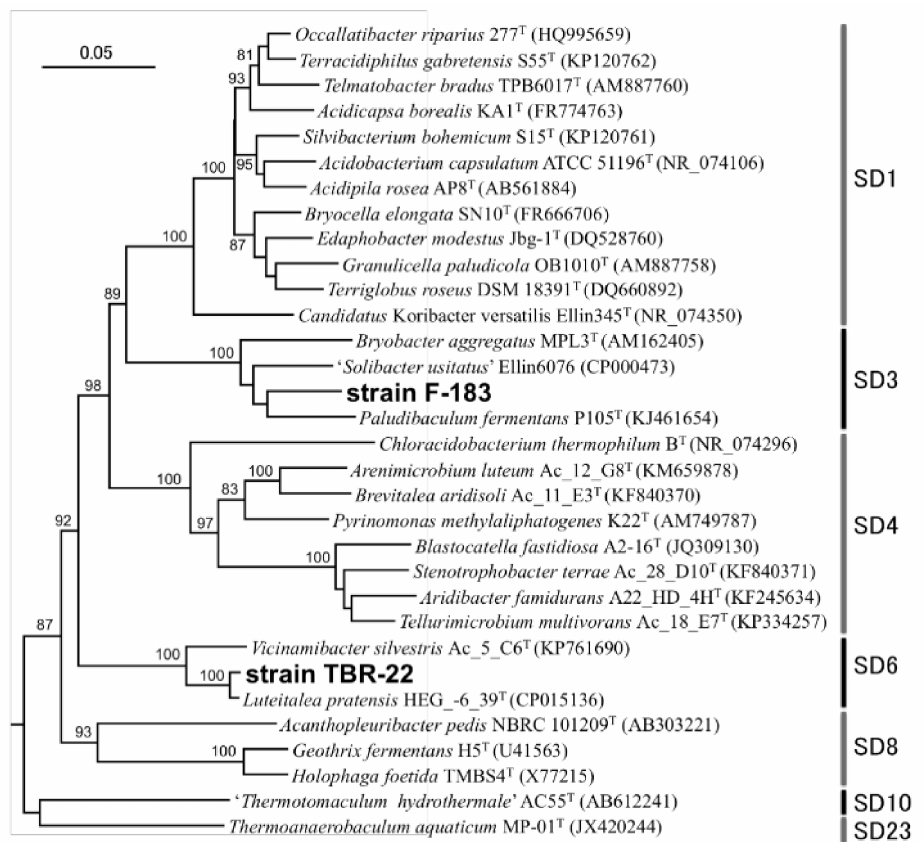
Figure 1. Phylogenetic relationship of the novel isolates and representative Acidobacteria species based on the 16S rRNA gene. The tree was constructed by Neighbor-joining methods. Planctomyces maris DSM 8797 T (AJ231184) and Rhodopirellula baltica SH 1 (NR_043384) were used as outgroups. Bootstrap values (>80) were calculated from 1000 replicates. SD, subdivision; bar, 5 nucleotide substitutions per 100